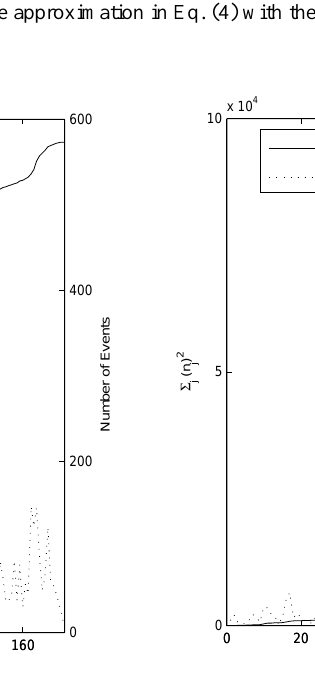
Fig. 7. Plot of Eq. (4) for Kidd Creek D (solid line) and the number of events recorded per time bin t (dashed lines).